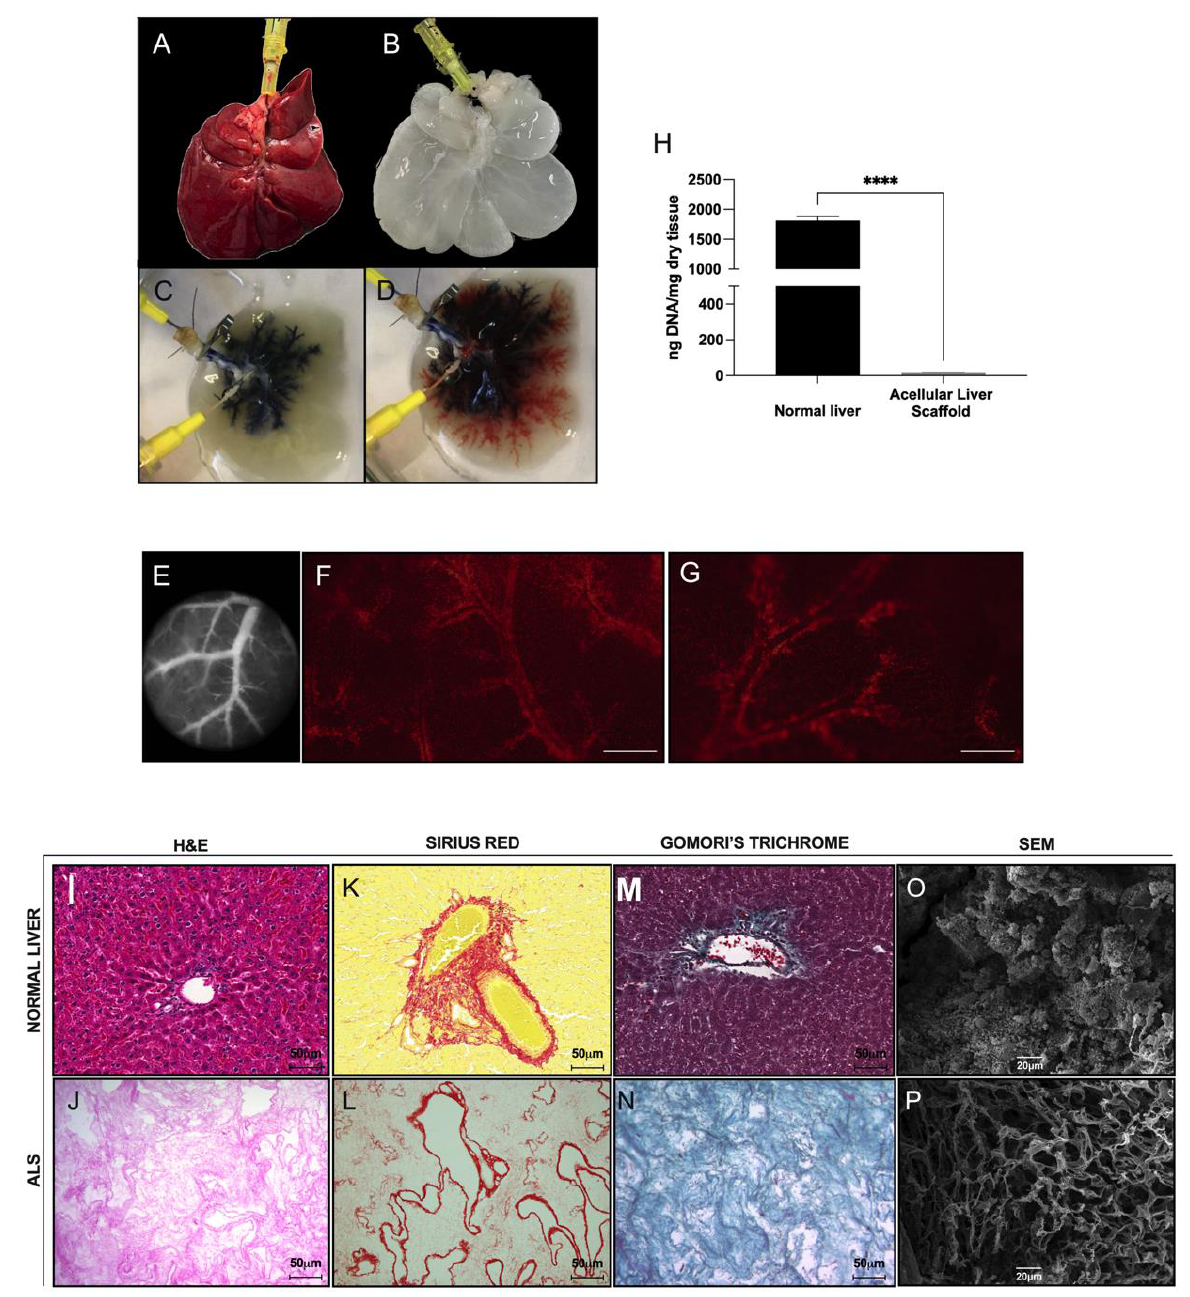
Figure 4. Rat liver decellularization and acellular liver scaffold characterization . Normal ( A ) and ALS ( B ) obtained by the decellularization process. Appearance of the vascular tree after toluidine blue and phenol red dye perfusion through the portal vein ( C ) and bile duct ( D ), respectively. A large branch of a preserved vascular tree was visualized using light ( E ) and intravital microscopy ( F , G ). Quantification of double-stranded DNA in ALS revealed a significant reduction in DNA compared to normal livers ( n = 3; significant differences were assessed by applying Student’s t -test, **** p < 0.0001) ( H ). H&E staining showed pink eosinophilic staining and no remaining nuclei or cytoplasm ( J ) in the scaffold compared with the normal liver ( I ). Sirius red ( L ) and Gomori’s ( N ) staining showed red- and green-based staining, indicating the presence of ECM proteins without any cellular presence. More intense staining was restricted to vessels in normal liver sections ( K , M ). Scale bars: 50 µ m. Scanning electron microscopy (SEM) images of the normal liver ( O ) and ALS ( P ) showing the spaces previously occupied by hepatic parenchymal cells. ( O ). Scale bars: 20 µ